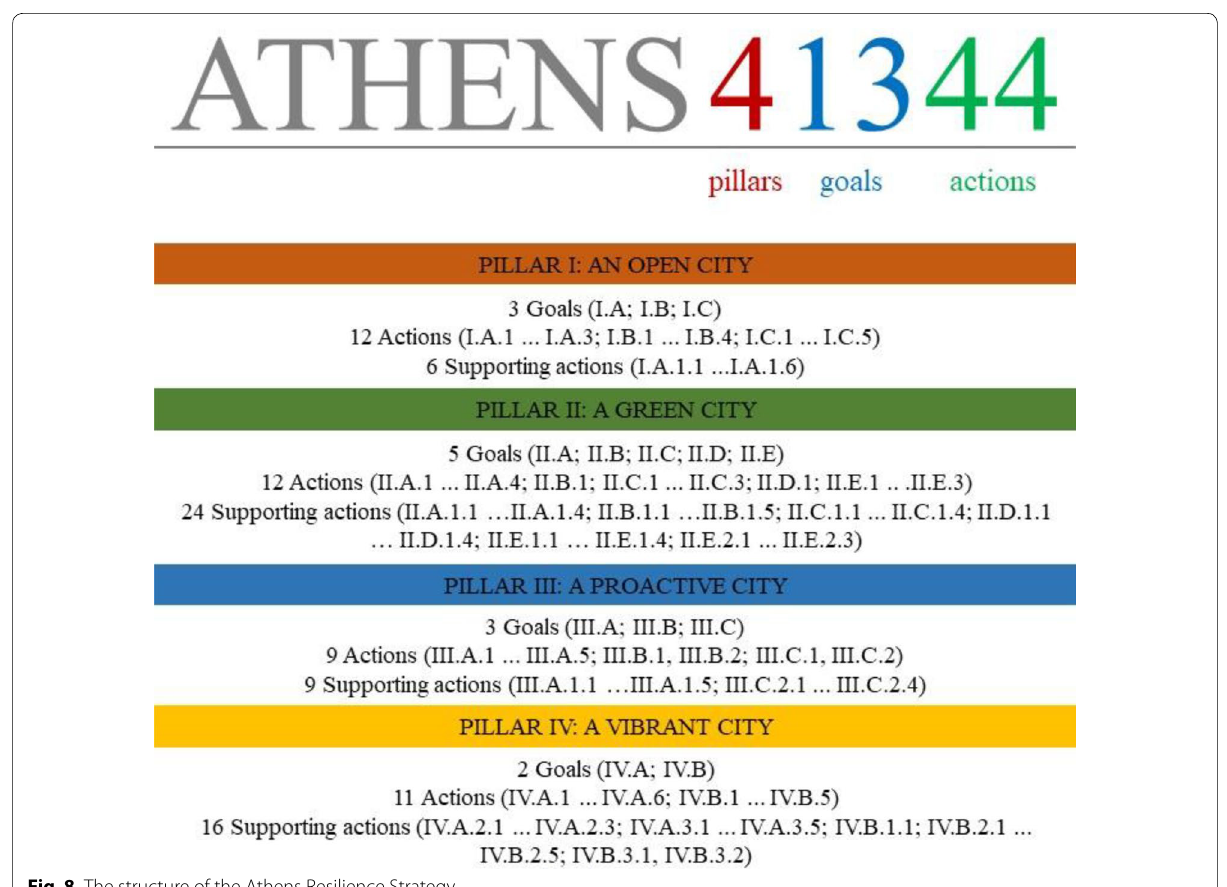
Fig. 8 The structure of the Athens Resilience